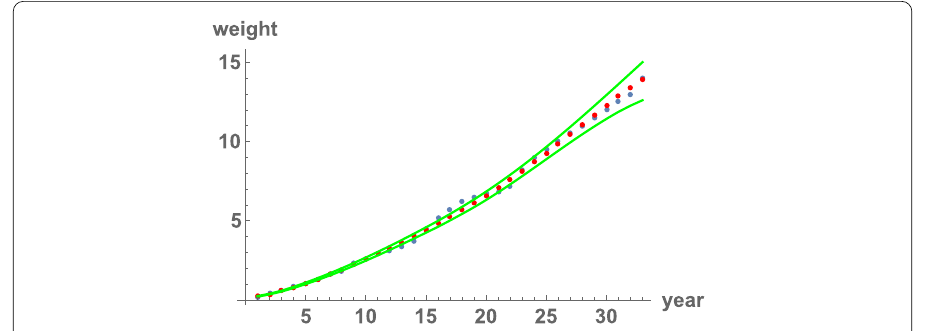
Figure 3 Fit of the fish weight data. The blue points represent the real weights, the red points represent the estimated weights (the mean) and the green lines cover a 95% confidence interval constructed by taking the quartiles in the Monte Carlo